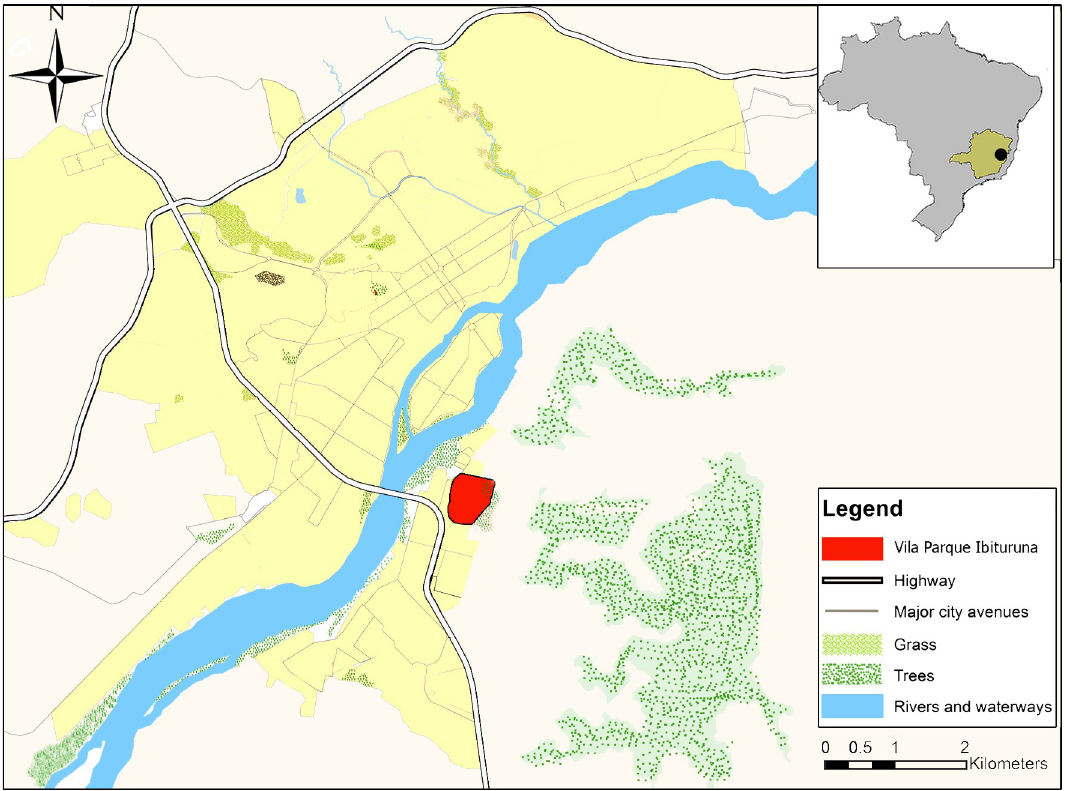
Fig 1. Map of the study area in the city of Governador Valadares. The upper right inset shows the location of the Minas Gerais State (green) in Brazil and the city of Governador Valadares (black circle). On the left, the region marked in red represents the neighborhood Vila Parque Ibituruna in Governador Valadares, where the sand flies were collected. The map was created using open data obtained from OpenStreetMap contributors.